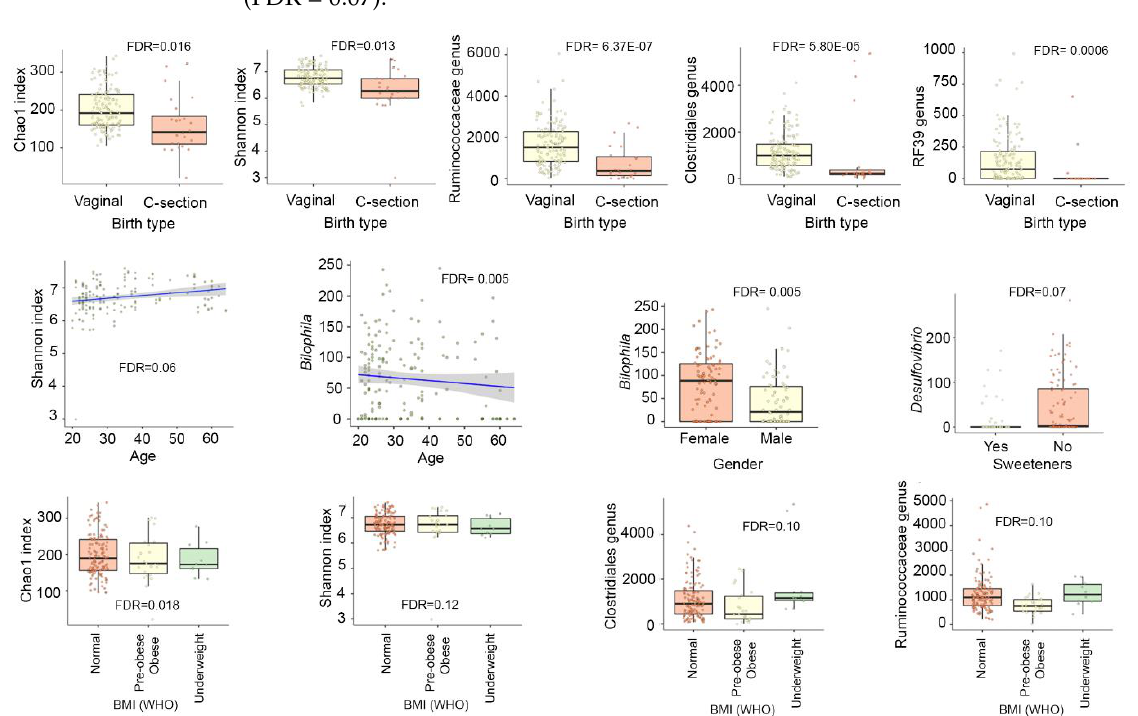
Figure 3. Association between participants’ characteristics and microbial diversity and taxa. Linear mixed models implemented in MaAsLin2 were used to analyse the microbiome and data on the characteristics of participants in the pilot and validation studies ( n = 84, 165 faecal samples). BMI, body mass index; WHO, World Health Organization.